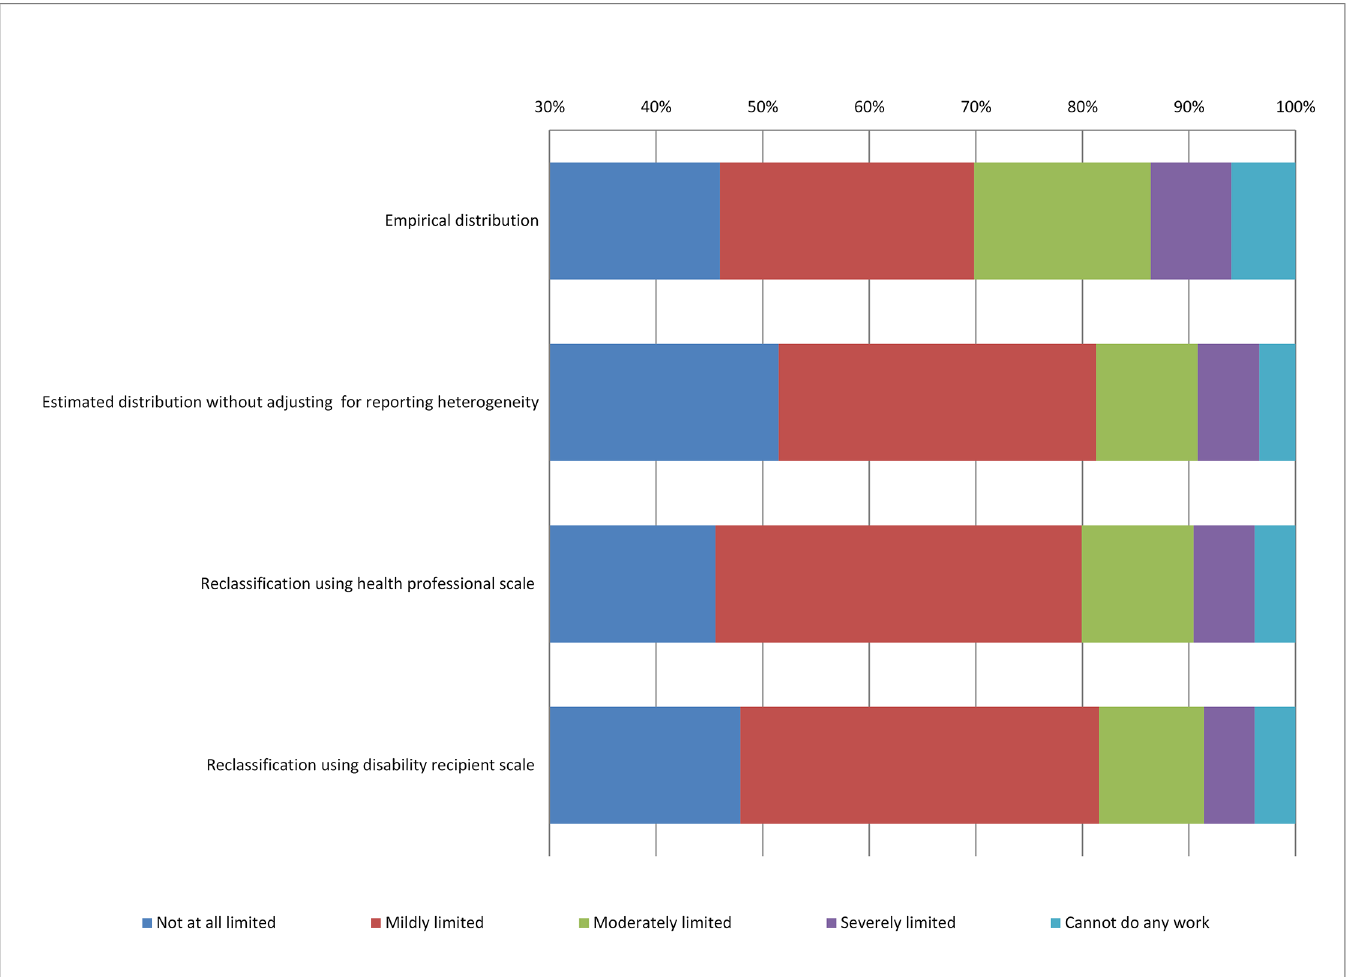
Fig 3. Distribution of Work Limitations (Application). “ Empirical distribution ” refers to the distribution of self-reported work limitations among HRS respondents who have participated in the vignette questionnaire. “ Estimated distribution without adjusting for reporting heterogeneity ” refers to the distribution of work limitations estimated using the HOPIT procedure but without adjusting reporting heterogeneity, which is similar to an ordered probit model. “ Reclassification using health professional scale ” and “ Reclassification using disability recipient scale ” refers to the distribution of work limitations adjusted for reporting heterogeneity in accordance with the estimated scales (based on Model 4 in Table 2) for health professionals (excluding nurses) and disability